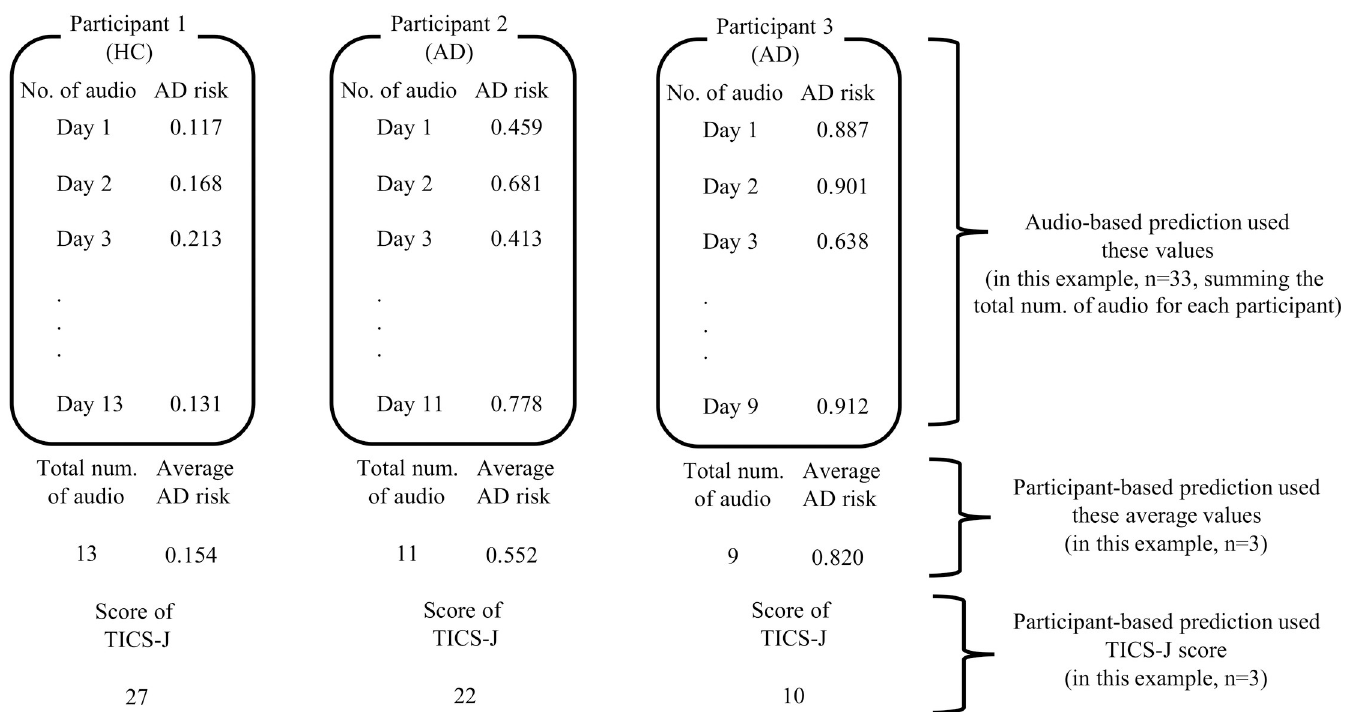
Fig 2. An illustration of the difference between audio-based prediction and participant-based